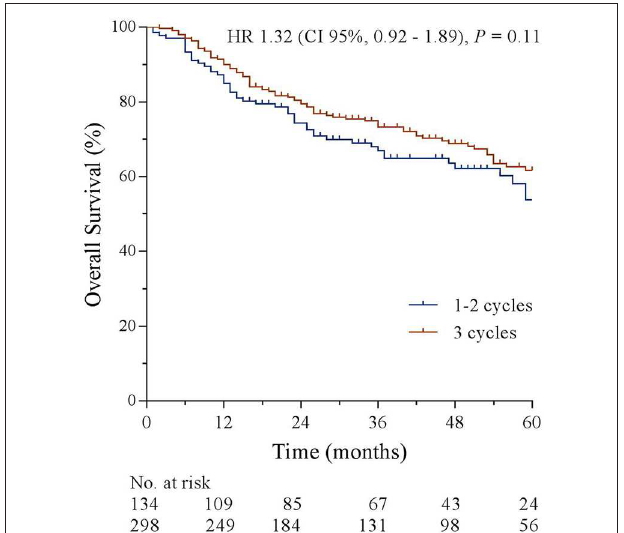
FIGURE 3 | Overall survival stratified by chemotherapy completion.